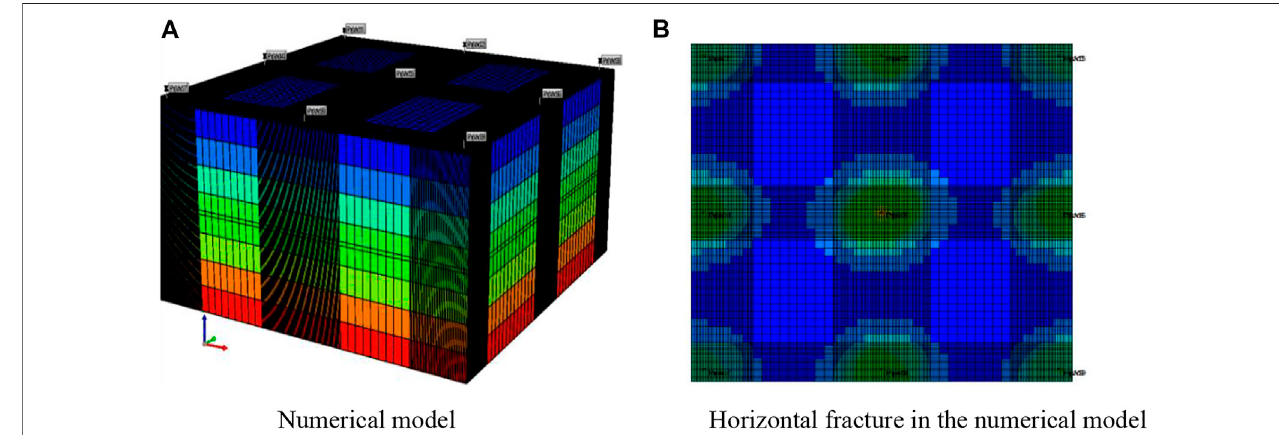
FIGURE 9 | Diagram of the reservoir numerical model. (A) Numerical model. (B) Horizontal fracture in the numerical model.